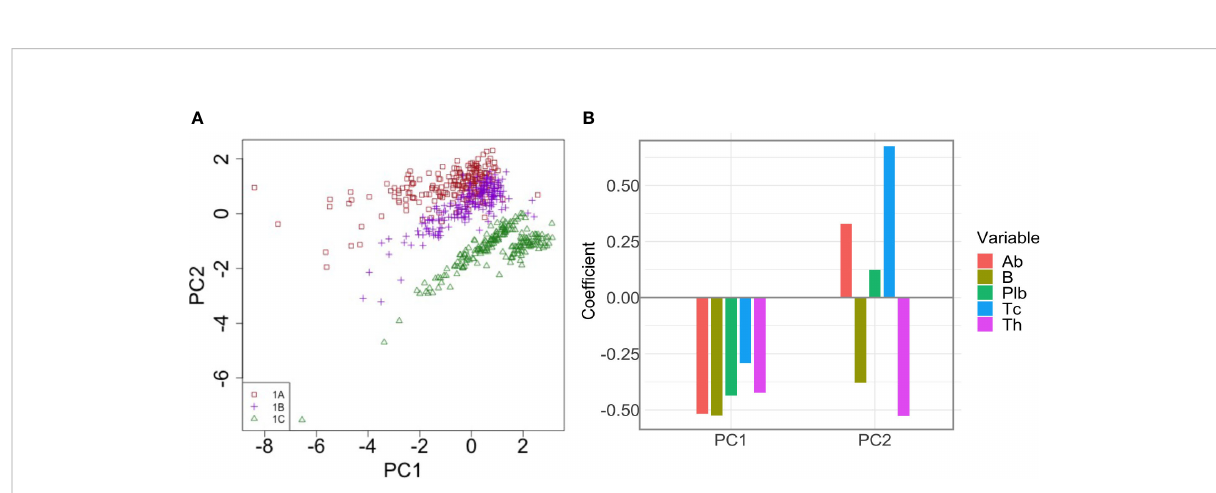
FIGURE 7 Principal Component Analysis of the correlation between pre-existing immunological memory at t 1 and the peak value of the antibody response to the second dose. (A) The dot plot shows PC1 and PC2 in individuals in treatment groups 1A, 1B and 1C. PC2 separates the different dosing protocols. (B) Loadings of PC1 and PC2. In PC2, Tc has the highest